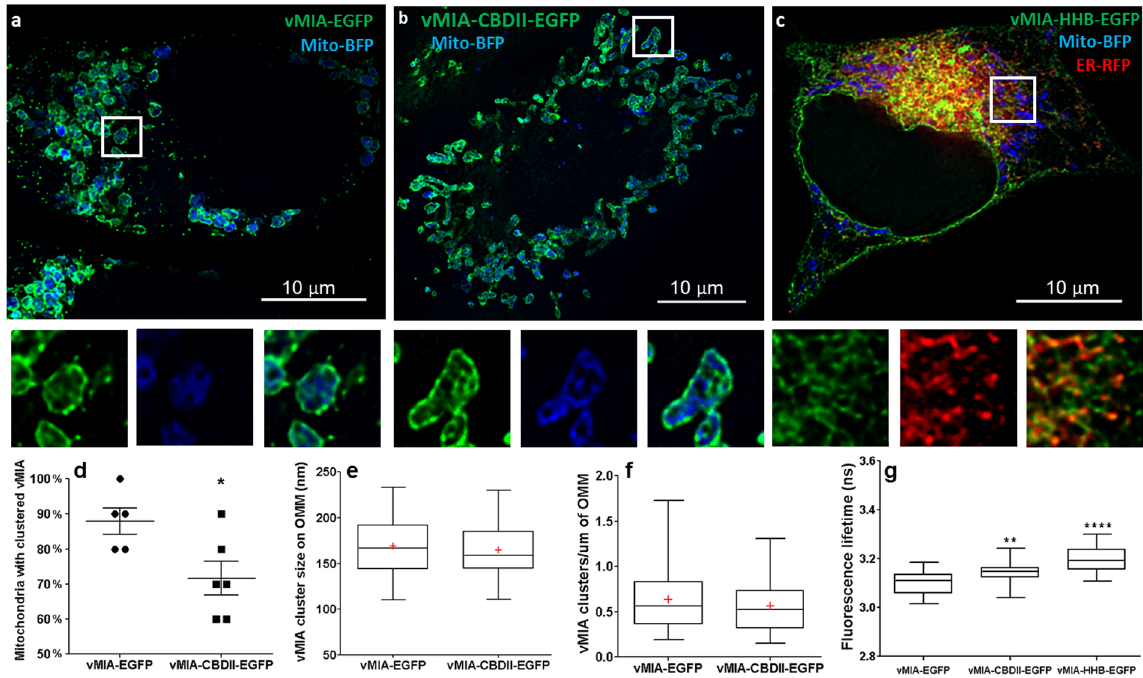
Figure 7. Analyses of vMIA HHB and CBDII mutant clustering by MSIM and FLIM. HeLa cells were transiently transfected with vectors expressing ( a ) vMIA-EGFP, ( b ) vMIA-CBDII-EGFP or ( c ) vMIA-HHB- EGFP (green) as previously described 36 . The cells were co-transfected with only a mitochondrial marker (Mito- BFP, blue) ( a , b ), or with Mito-BFP and an ER marker (ER-RFP, red) ( c ). Cells were fixed and a single plane from an MSIM z-stack image showing distribution of vMIA-EGFP and mitochondrial and ER marker is shown. A zoom of regions marked by the white boxes in each image is shown below. ( d ) The percentages of mitochondria with clustered vMIA in HeLa cells expressing vMIA-EGFP (88.0 ± 3.7%, n = 5 cells) or vMIA-CBDII-EGFP (71.7 ± 4.8%, n = 6 cells). ( d ) The size of vMIA (mean 169.18, min: 110, median 167, max: 233, n = 50) and vMIA-CBDII (mean 164.55, min: 111, median 159, max: 230, n = 60) clusters were determined. p = 0.4024. The lines and red crosses indicate the medians and means, respectively. ( f ) The number of vMIA clusters in HeLa cells expressing vMIA-EGFP (mean 0.638, min: 0.194, median 0.562, max: 1.73, n = 50) or vMIA-CBDII-EGFP (mean = 0.563, min: 0.153, median 0.526, max: 1.312, n = 60) were determined (p = 0.3118). The line and red, cross mark indicate the median and mean, respectively. ( g ) vMIA-HHB and vMIA-CBDII are defective in dimerization as measured by FLIM. Shown are the fluorescence lifetime comparisons of vMIA-EGFP ( τ = 3.10 ± 0.009 ns), vMIA-CBDII-EGFP ( τ = 3.14 ± 0.007 ns) and vMIA-HHB-EGFP ( τ = 3.2 ± 0.008 ns). * Represents p < 0.03, ** represents p < 0.003, **** represents p =